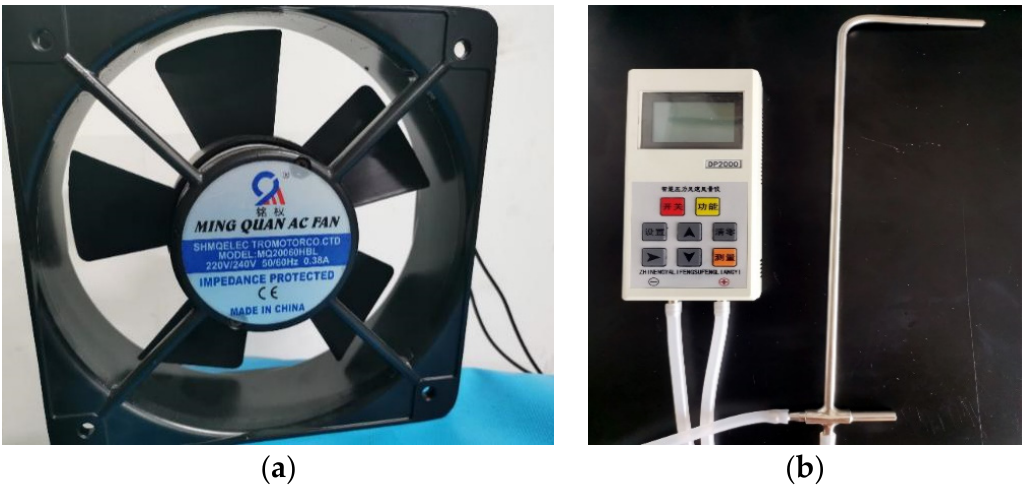
Figure 13. ( a ) Physical drawing of adjustable speed experimental fan. ( b ) Anemometer.